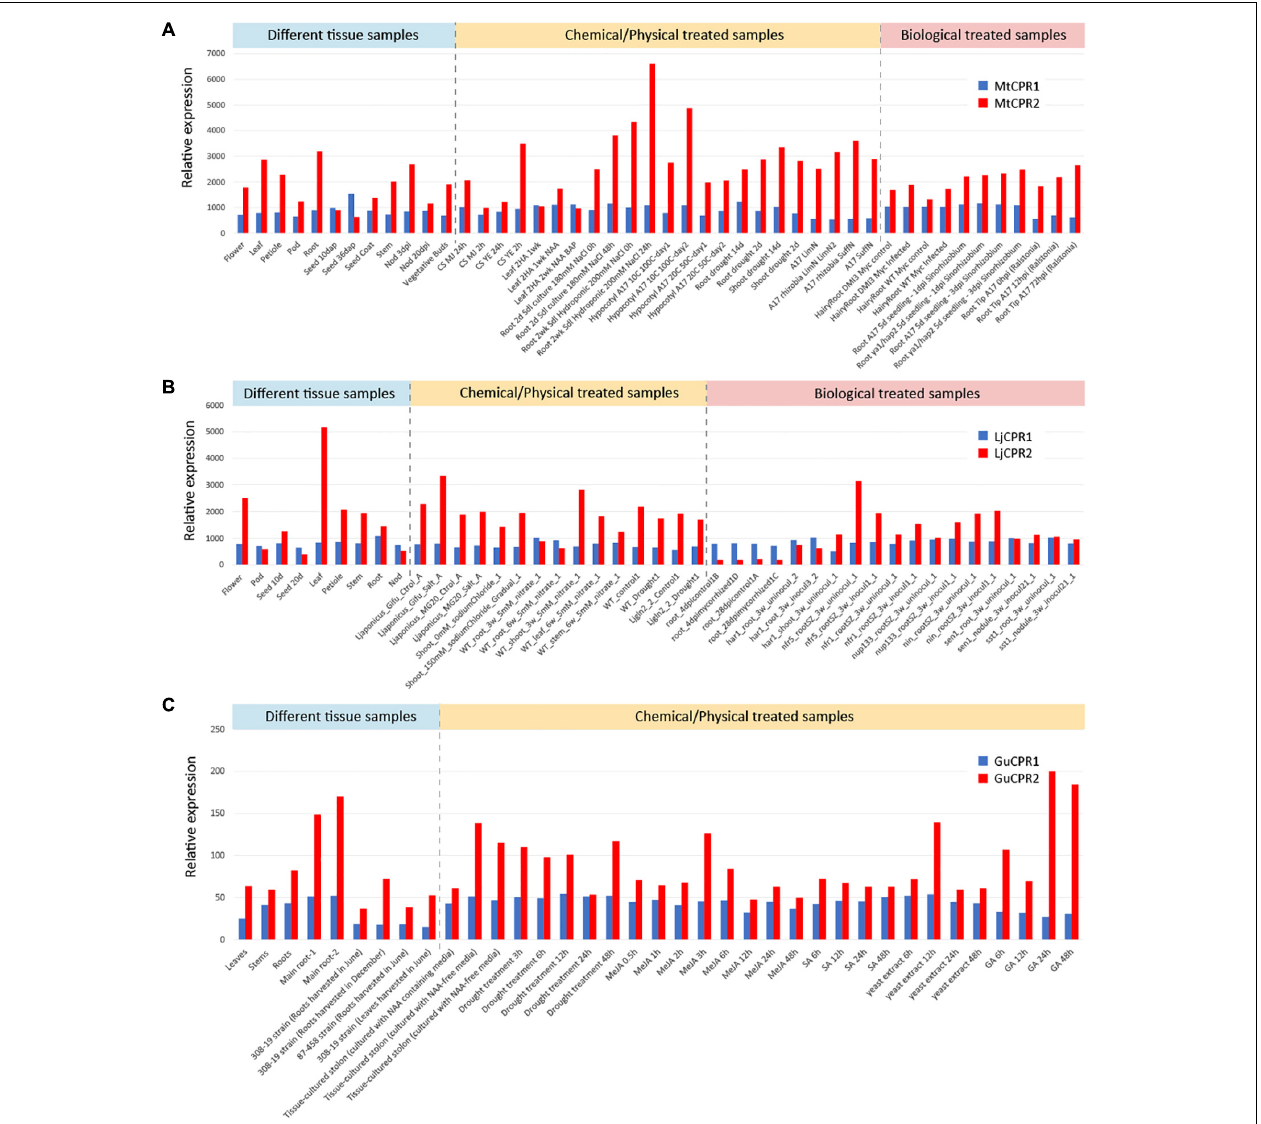
FIGURE 5 | Co-expression analysis of CPR class I and II from (A) M. truncatula , (B) L. japonicus , and (C) G. uralensis using selected transcriptomic data-sets representing samples from different tissue, chemical/physical treatments, and biological treatments. Transcriptomic data-sets of M. truncatula and L. japonicus were obtained from https://mtgea.noble.org/v3/index.php and https://lotus.au.dk/ofMG-20version3.0. The G. uralensis transcriptomic data-set was obtained using RNA-seq analysis in this